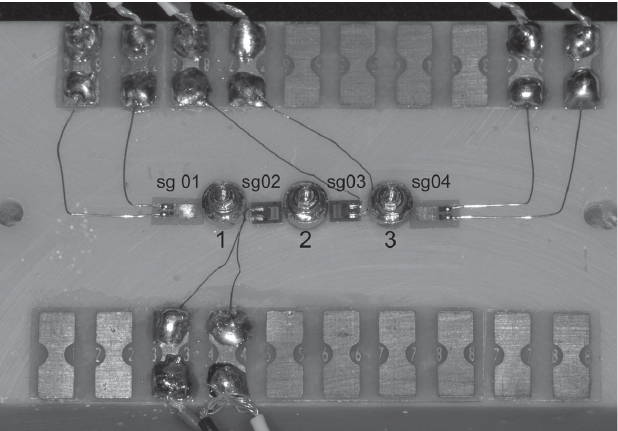
Fig. 2 - Strain gauges around the microunit abutments.